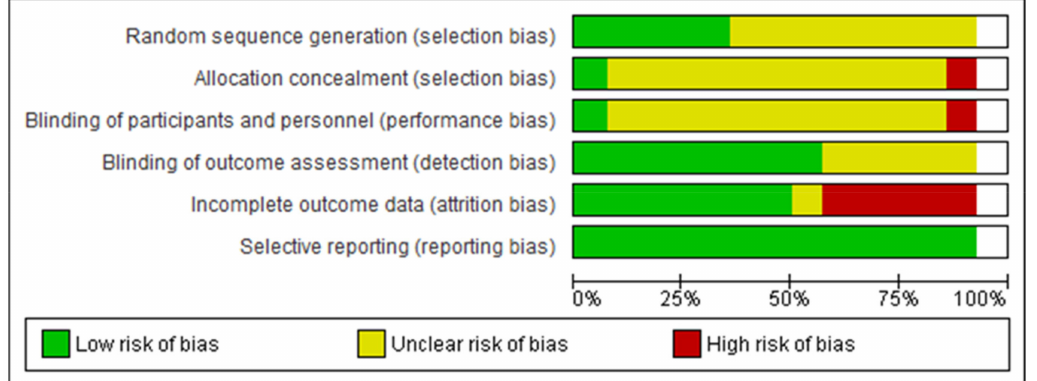
Figure 2. Review authors’ judgements about each risk of bias item presented as percentages across all meta-analysis